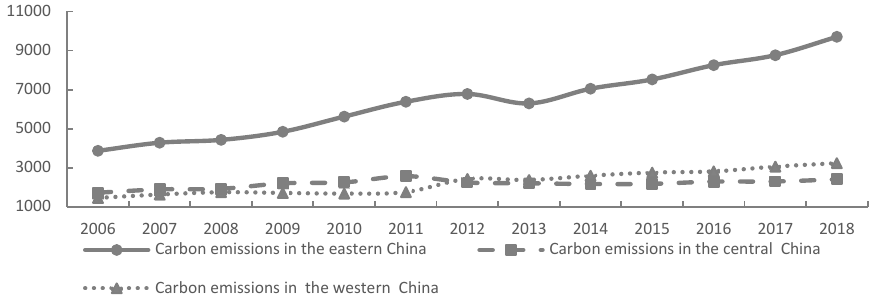
Figure 4. Estimation of the energy consumption of tourism by regions of China, 2006 to 2018.